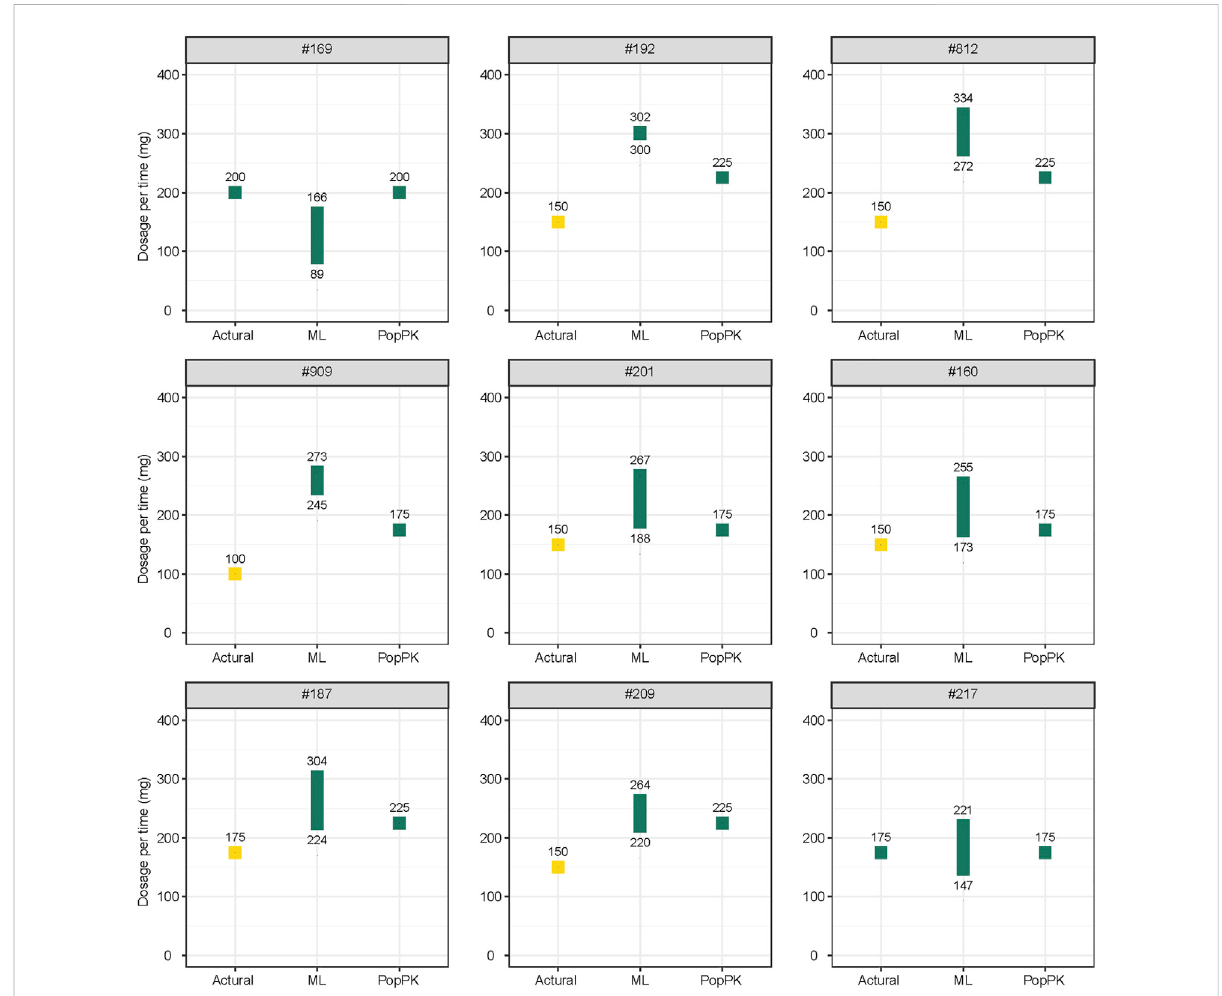
FIGURE 4 ComparisonoftheactualandoptimaldailydosesofcyclosporinerecommendedbythemostsuitableMLmodelandpopPKmodels.Yellowplot indicates the concentration below the therapeutic windows; green plot indicates the concentration in the therapeutic windows. All doses are recommended twice daily. ML, machine learning; popPK, population pharmacokinetic